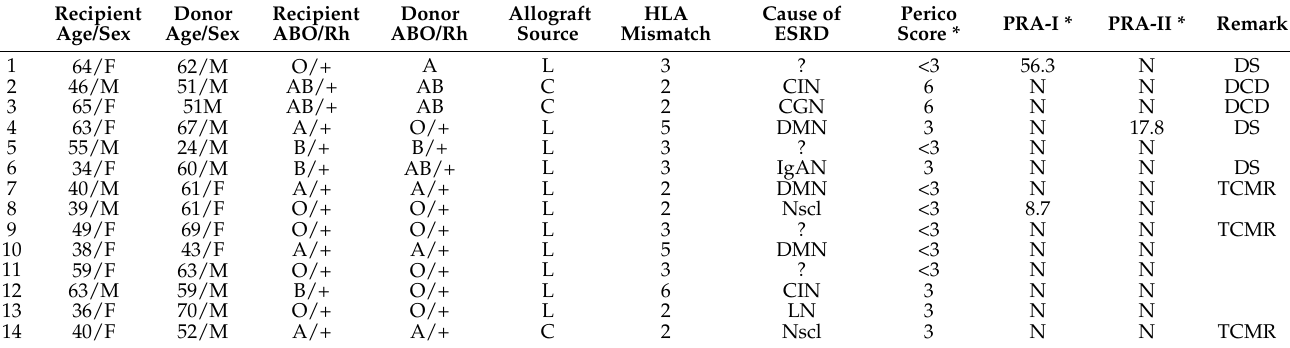
Table 1. Basic demographic features of 14 renal transplant patients.